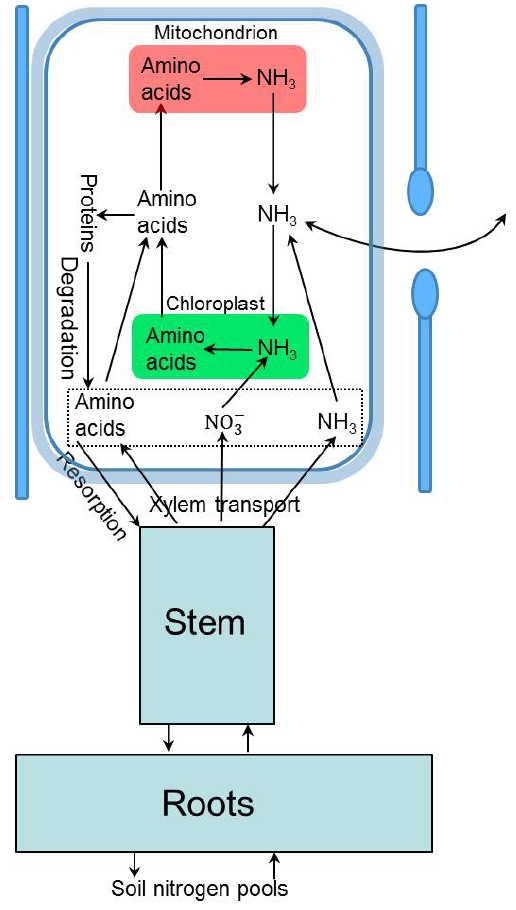
Figure 5. Intra-plant nitrogen cycling and flux exchanges with ex- ternal